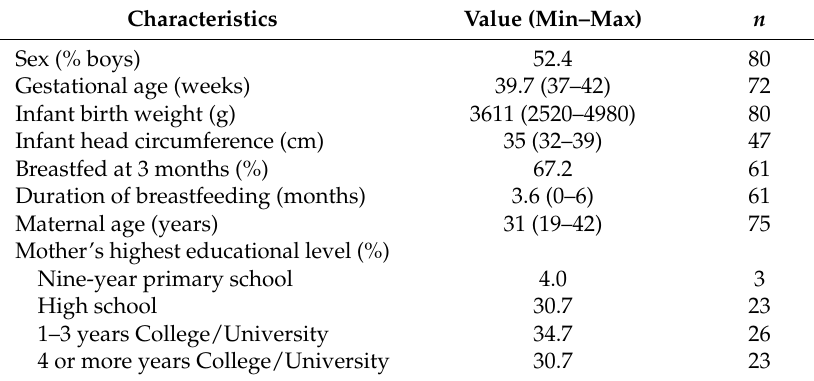
Table 1. Sample characteristics ( n =